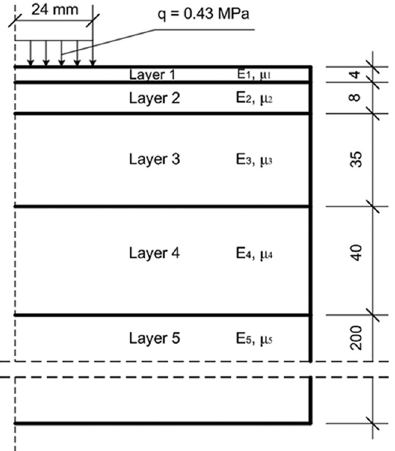
Fig. 14. Pavement structure model adopted for the calculations